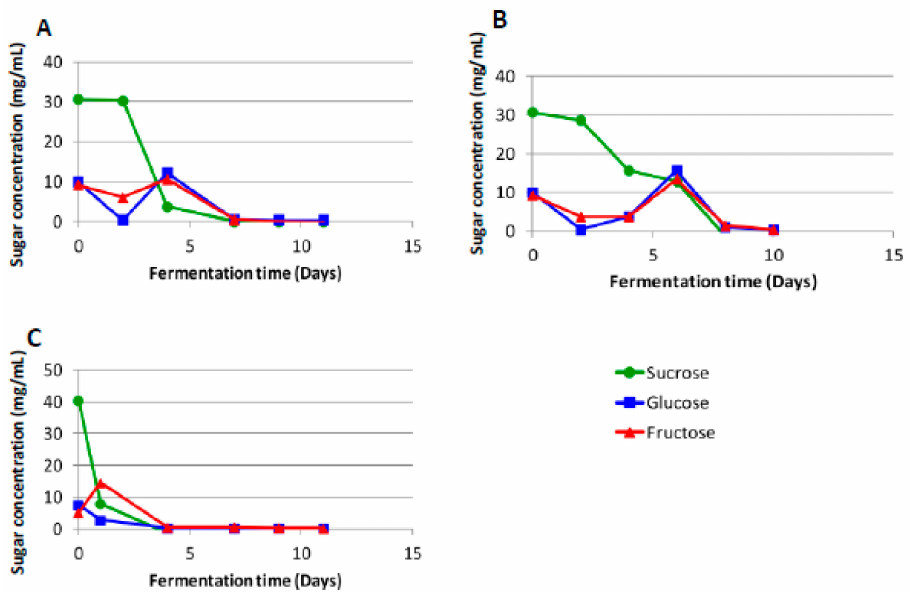
Figure 2. Changes in the sucrose, glucose and fructose levels in the marula ( A ) Lab, ( B ) Mentz and